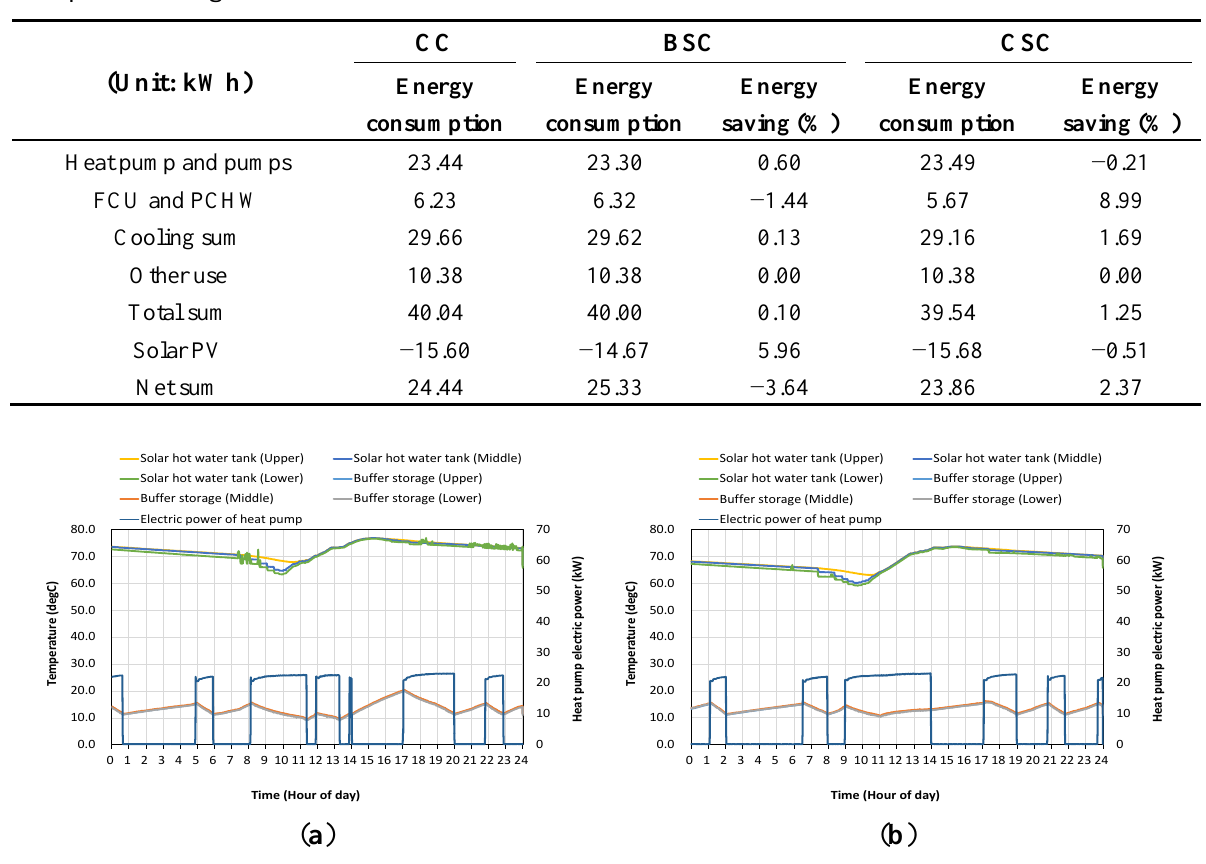
Table 4. Electricity consumption for the whole day for three different control strategies for space-cooling-mode tests.